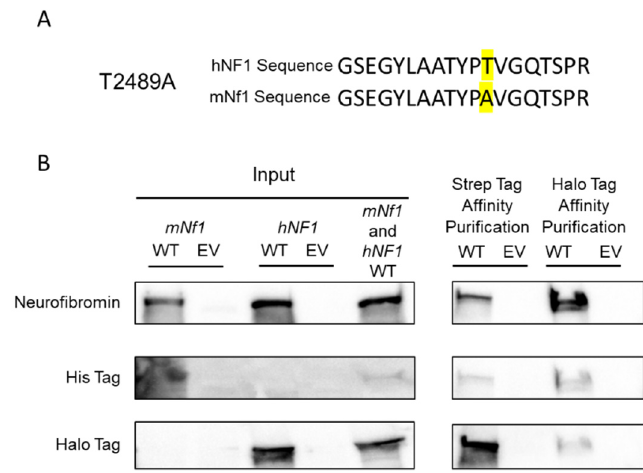
Figure 2. ( A ). The top row details the amino acid sequence of the fragment of human NF1 protein that affinity purified from WT HEK293 cells with the tagged mNf1 cDNA. The second row depicts the homologous mouse neurofibromin protein sequence and highlights the non-conserved amino acid residue T2489A. ( B ). Reciprocal immunoprecipitation of the tagged murine and human cDNAs. The left-hand side shows blots of input lysates after cell transfections with each indicated cDNA prior to affinity purification. The right-hand side shows blots after affinity purification. The left two columns show the Strep tag affinity purification and the right two columns show the Halo tag affinity purification. WT indicates the co-transfection of both cDNAs into HEK293 NF1 null cells; while EV indicates the empty vector transfection into the same cells. The first row of immunoblots is the visualization of neurofibromin. The second row shows the His tag from the mNf1 cDNA. The third row depicts the Halo tag from the hNF1 cDNA. The His tag is visible in the Halo immunoprecipitation WT lane and the Halo tag is visible in the Strep tag affinity purification WT lane, indicating that the two tagged neurofibromins are purifying the reciprocal neurofibromin when the individual affinity purification is completed.